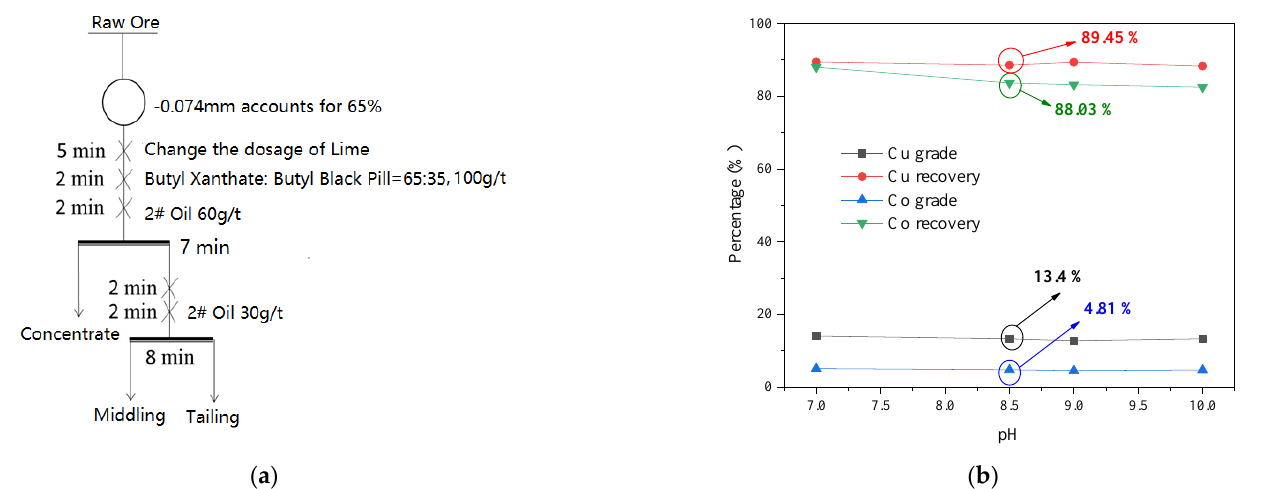
Figure 9. Effect of pH on the recovery of sulfide aggregates. ( a ) The flow chart for flotation experiments ( b ) Effect of Ph on the flotation recovery.